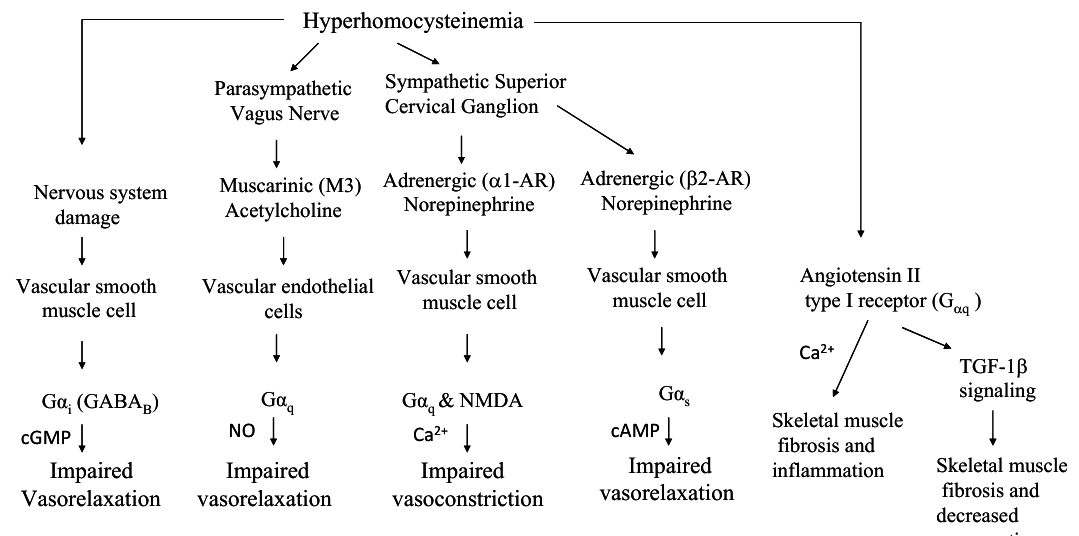
Figure 2. The HHcy modulation of sympathetic and parasympathetic nervous system and GPCRs are presented in the schematic diagram. Such modulation is observed to cause impairment in vascular responses to the regulatory signals. HHcy might damage the nervous system involving both parasympathetic and sympathetic system and disrupt autonomous regulation of hemodynamics [63]. Under normal circumstances, sympathetic stimulation activates either adrenergic α 1-AR or β 2-AR, which is G α or G α type of GPCRs respectively q s in the vascular smooth muscle. Agonist (Norepinephrine) binding to the α 1-AR leads to the activation of phospholipase C through G α . This process eventually leads to the synthesis q of second messengers Inositol triphosphate (IP3) and diacylglycerol (DAG). IP3 further releases Ca 2+ from the internal stores and eventually produces muscle contraction by activating myosin light chain kinase (MLCK) present in the smooth muscles [83,87]. In addition, NMDA receptors can also be activated in the presence of activated PKC and other Src tyrosine kinases and increases Ca 2+ influxes from the cell exterior [88]. Binding of agonist (Norepinephrine) to β 2-AR leads to activation of adenylyl cyclase and results in cAMP production. cAMP inhibits MLCK through PKA (protein kinase A) and produces vasorelaxation [89]. Activation of the vagus nerve stimulates muscarinic acetylcholine receptors in the vascular endothelial cells which results in increased release of Ca 2+ ions